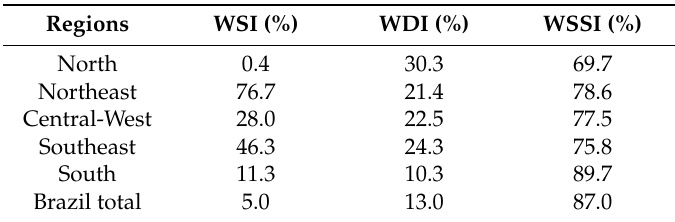
Table 3. Mean values in water scarcity index (WSI), water dependency index (WDI) and water self-sufficiency index (WSSI) per Brazilian